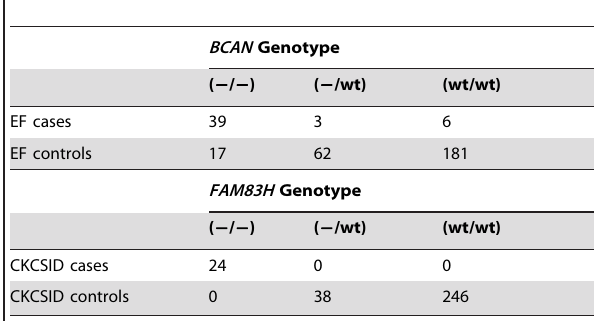
Table 1. Summary of genotyping results on the panel of 308 dogs assayed for the BCAN , 16 kb deletion and the FAM83H 1 bp